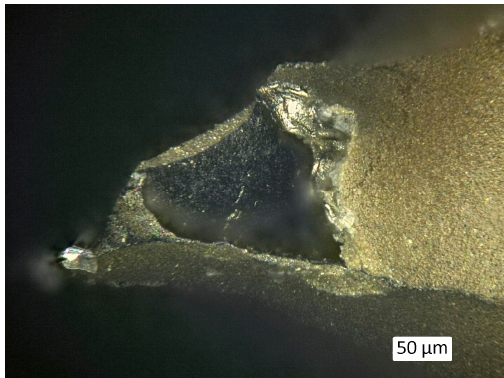
Figure 7. SEM images of hollow struts of filler-free foams at different degrees of pyrolysis; ( a ) 300 °C, ( b ) 600 °C, ( c ) 1000 °C.